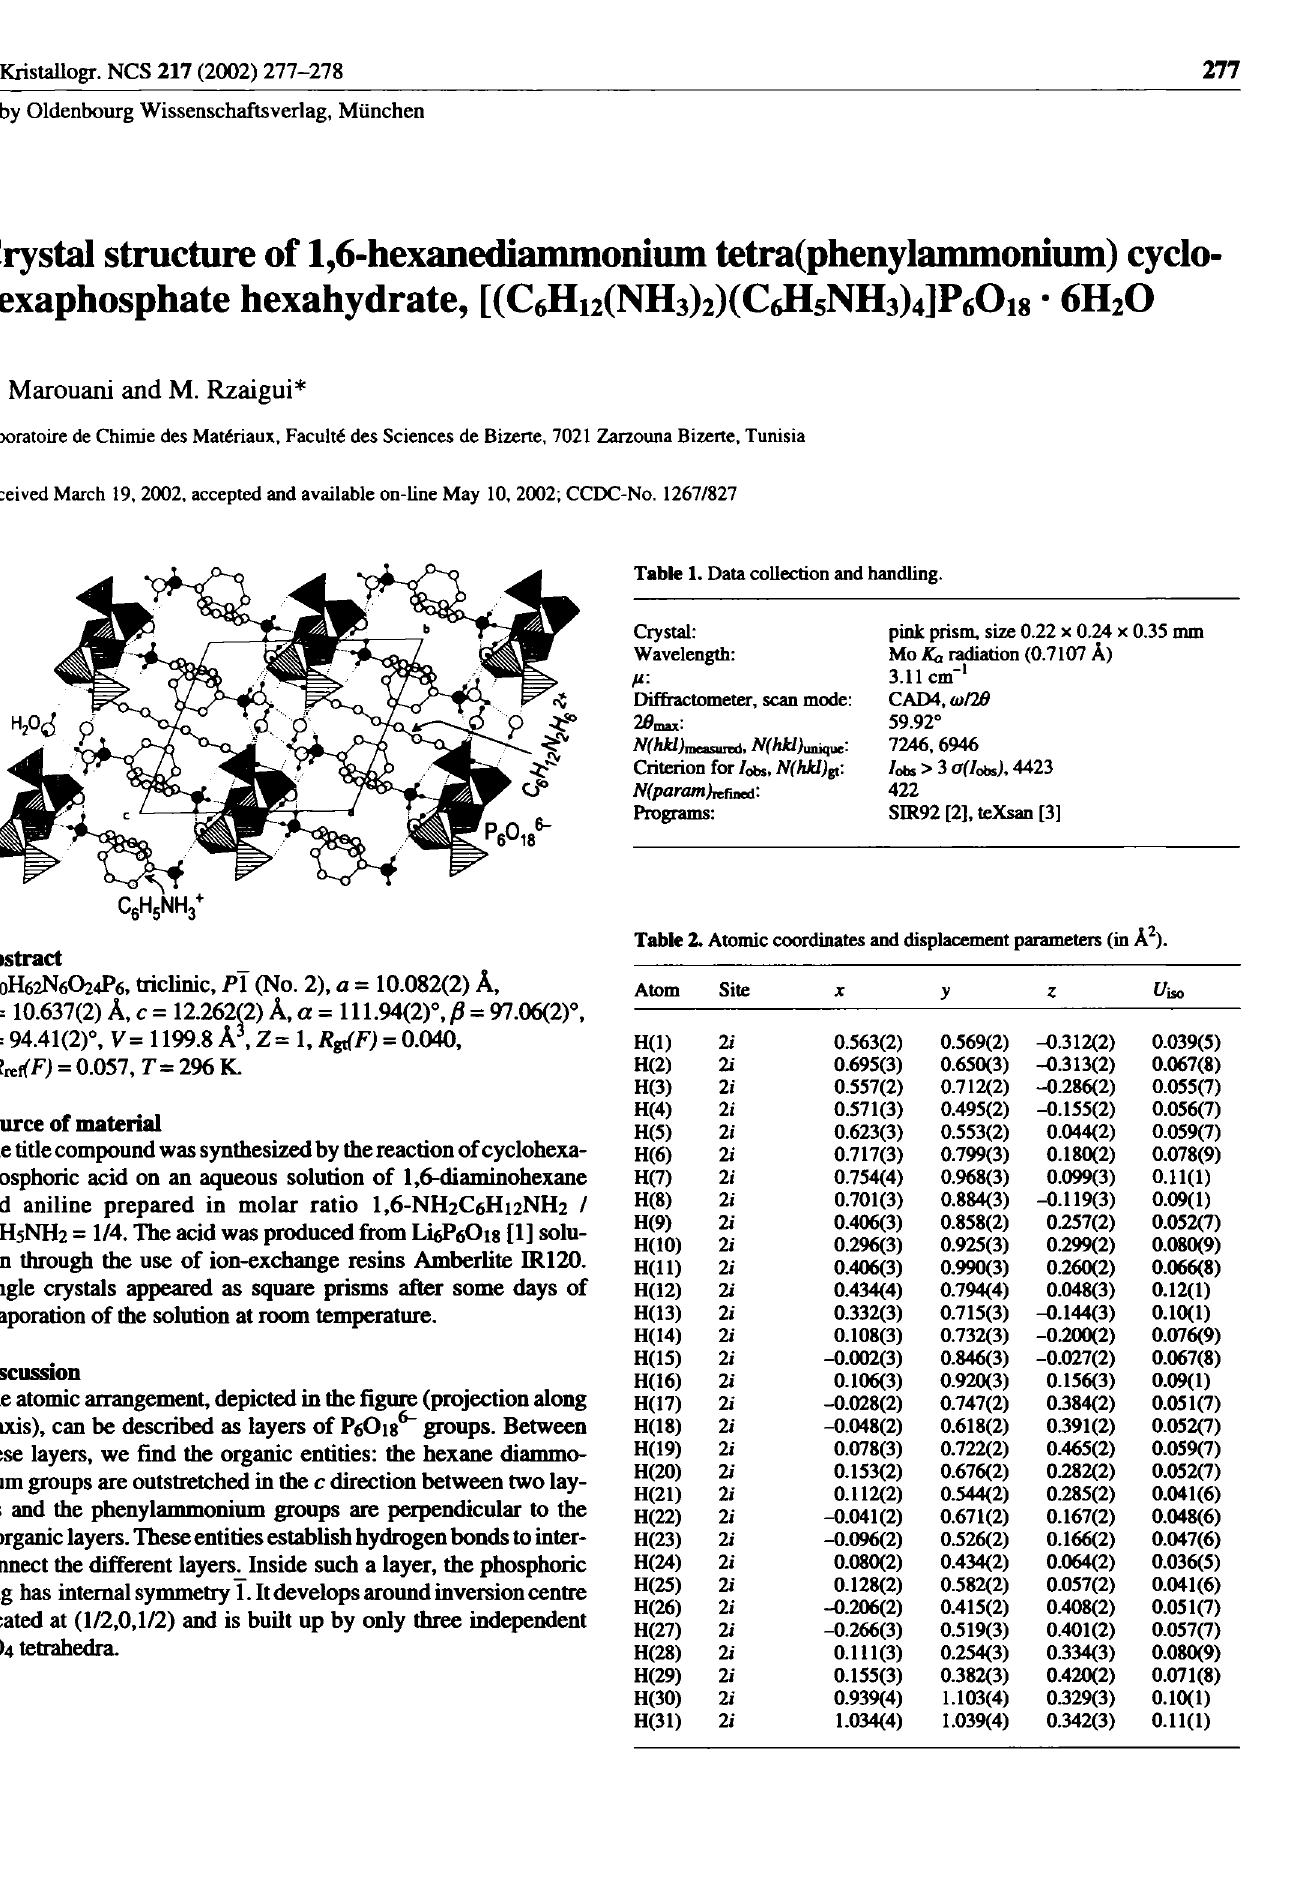
Table 2. Atomic coordinates and displacement parameters (in Â 2